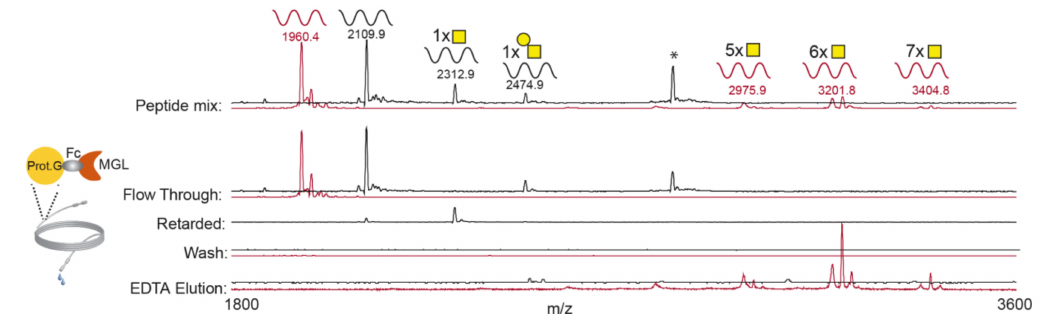
Figure 1. Macrophage galactose-like C-type lectin (MGL)-based lectin weak a ffi nity chromatography (LWAC). MS spectra of IgA heavy chain (IgA-H; red) and podoplanin (PDPN; black) peptides and glycopeptide mixture employed: naked peptides (IgA-H and PDPN, respectively), Tn-glycopeptides carrying di ff erent amounts of Tn residues (IgA-H with 5, 6, or 7 Tn-residues) and T-(1T- PDPN) and Tn-(1Tn- PDPN) carrying peptides. MS spectra of distinct chromatography fractions are reported. * unknown impurity. Peptide sequences are listed in Table